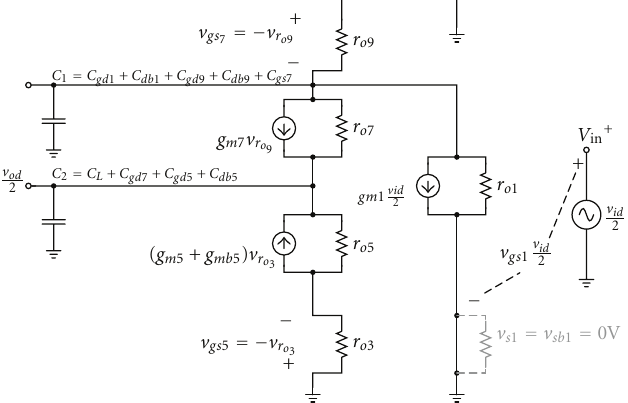
Figure 13: OTA half di ff erential small signal